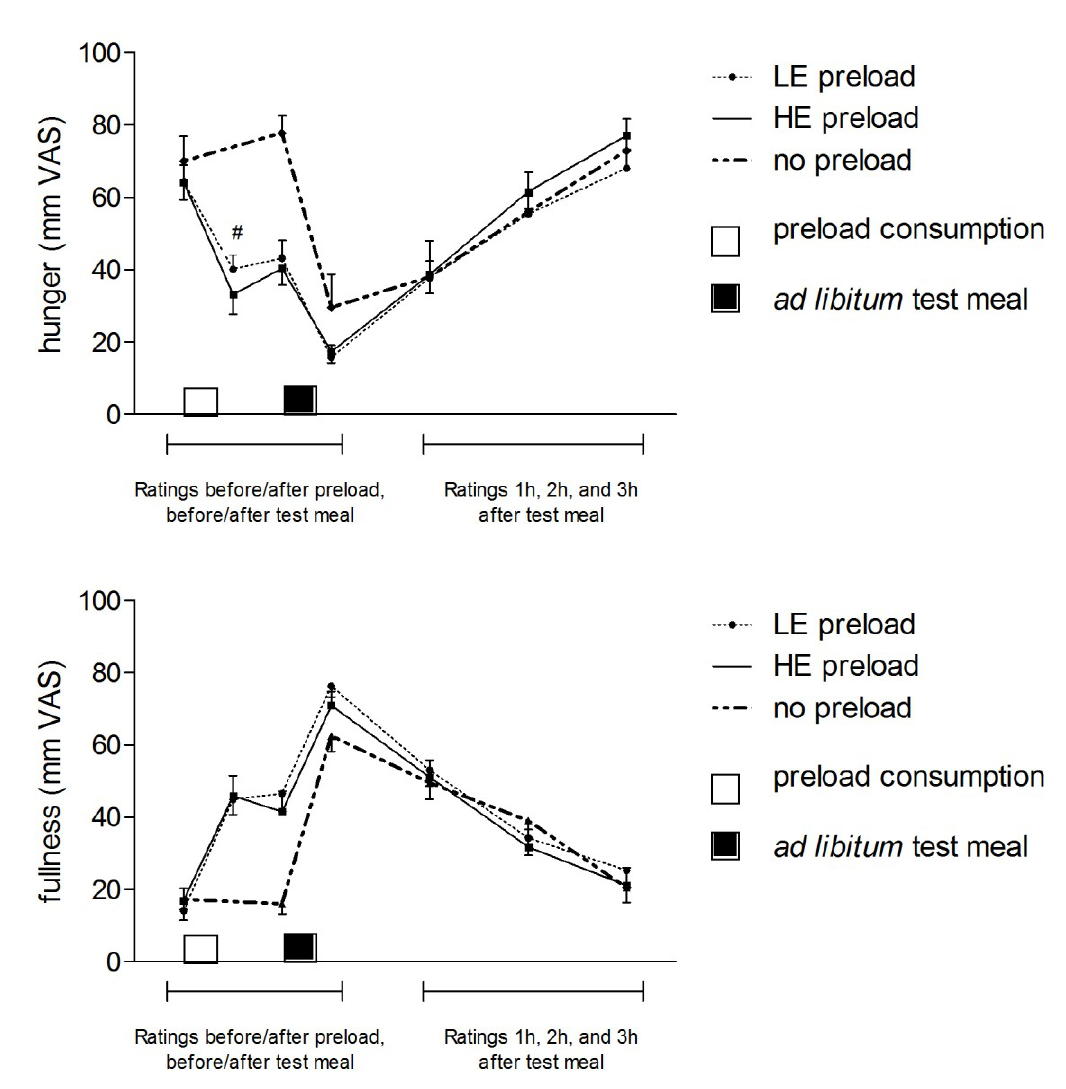
Figure 2. Mean values (mm VAS ± SEM) of self-reported hunger and fullness ratings when consuming no preload or the low-energy (LE) or high-energy (HE) preloads. The small blocks on the x-axis represent consumption of the preload (white block) and the ad libitum test meal (black block). # The difference in hunger ratings between LE and HE preload directly after consumption was borderline